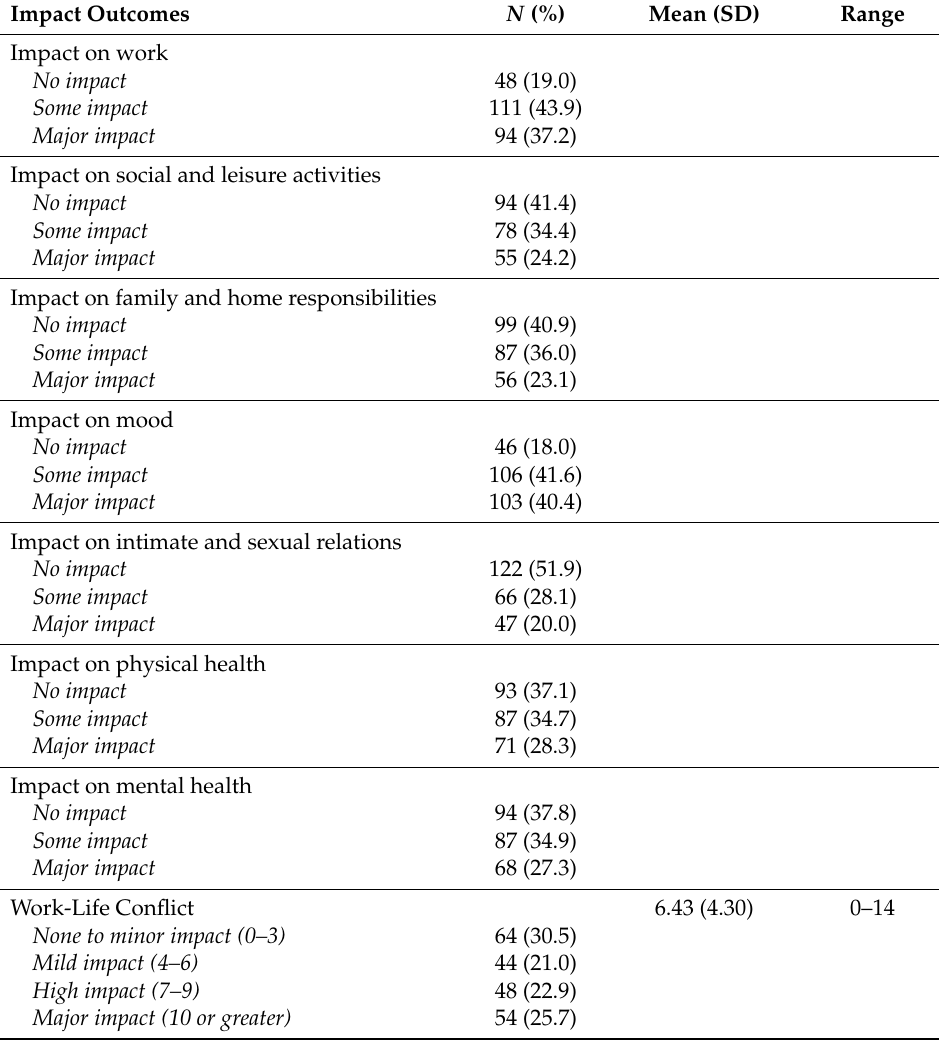
Table 3. Sleep’s impact on